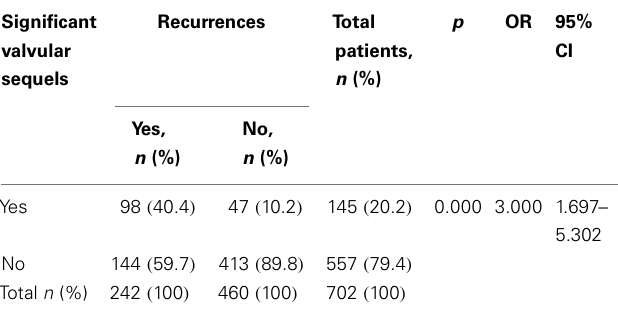
Table 2 | Prevalence of significant valvular sequels according to the presence of recurrences